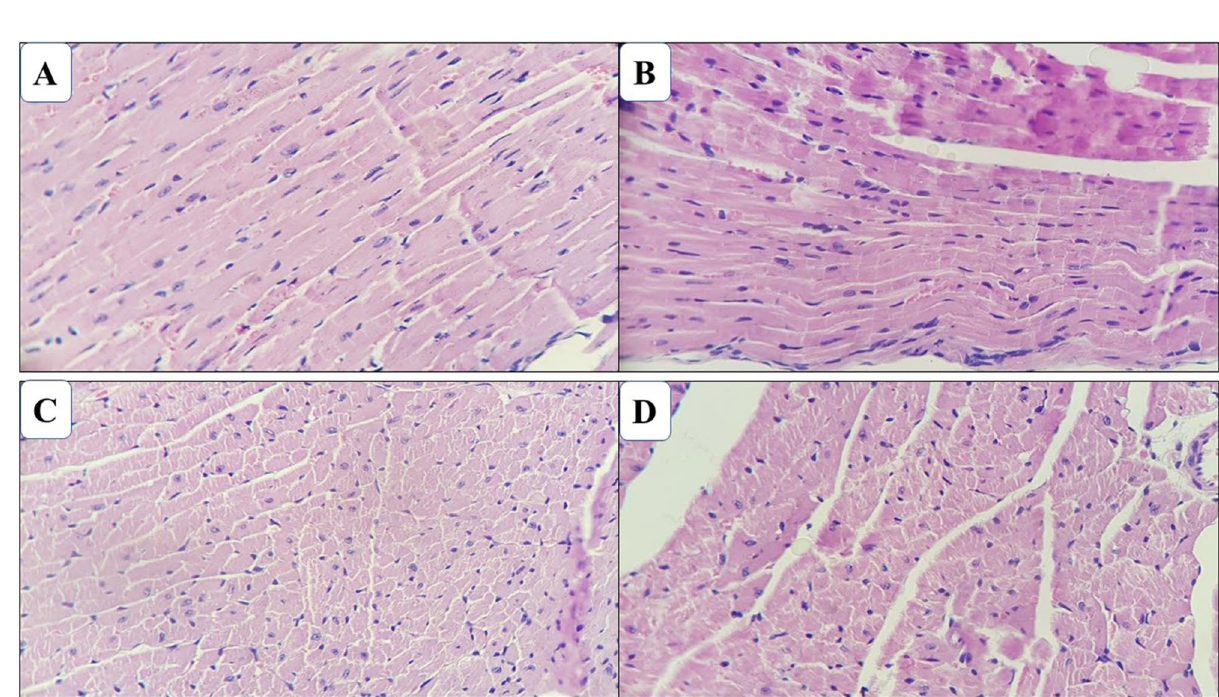
Figure 5. Photomicrograph of the heart of mice treated with ethanol extract and alkaloid fraction of Aspidosperma nitidum . ( A ) Group treated with ethanol extract; ( B ) control group (water:DMSO); ( C ) group treated with alkaloid fraction; ( D ) control group